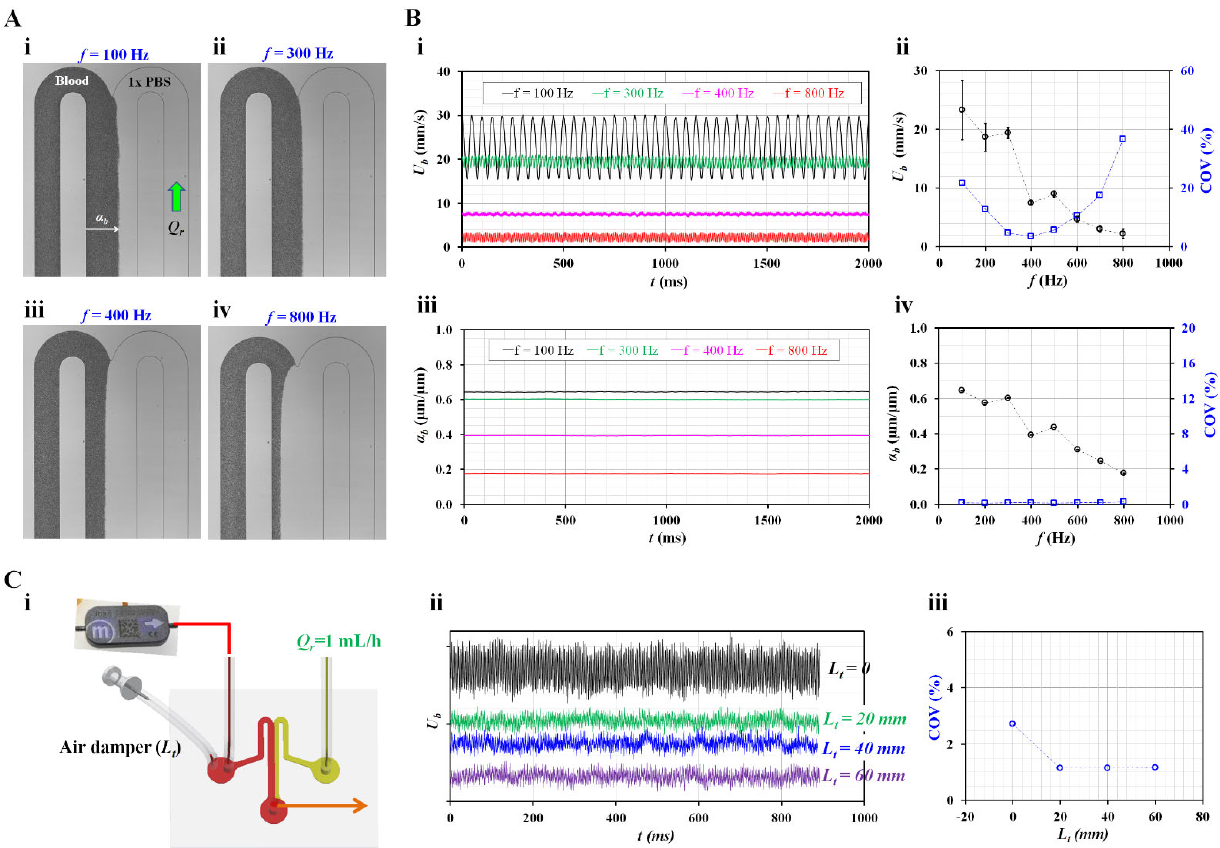
Figure 3. Quantitative evaluation of blood flow delivered by micro pump and blood flow stabilization with air damper. ( A ) Microscopic images showing variations of interface with respect to operational